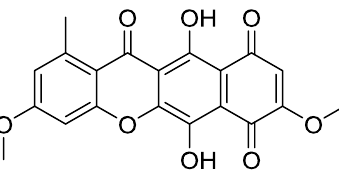
Figure 5. The chemical structure of bikaverin (6,11-dihydroxy-3,8-dimethoxy-1-methylbenzo[ b ]xanthene-7,10,12-trione), first isolated from the culture of Fusarium vasinfectum [28].